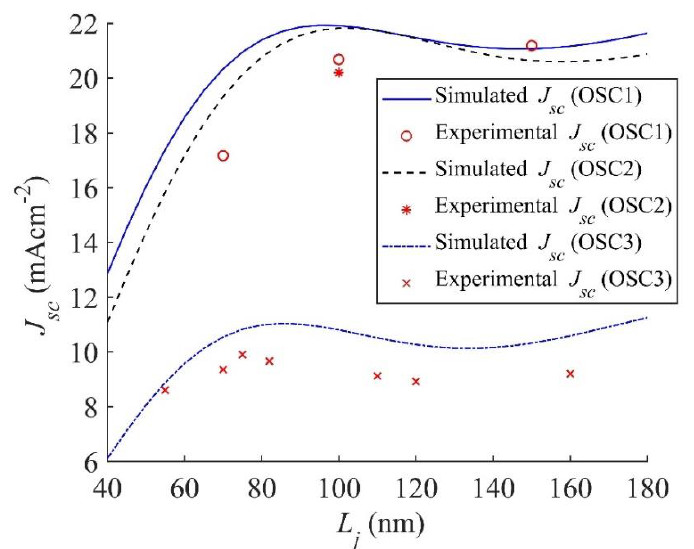
Figure 4. Simulated J sc of OSC1 of the structure Glass/ITO/ZnO/PBDB-T-SF:IT4F/MoO 3 /Al, OSC2 of the structure Glass/ITO/PEDOT:PSS/PBDB-T-SF:IT4F/PFN-Br/Al and OSC3 of the structure Glass/ITO/PEDOT:PSS/P3HT:PCBM/LiF/Al are plotted as a function of the thickness of the active layer along with their experimental results from [47,49–51],